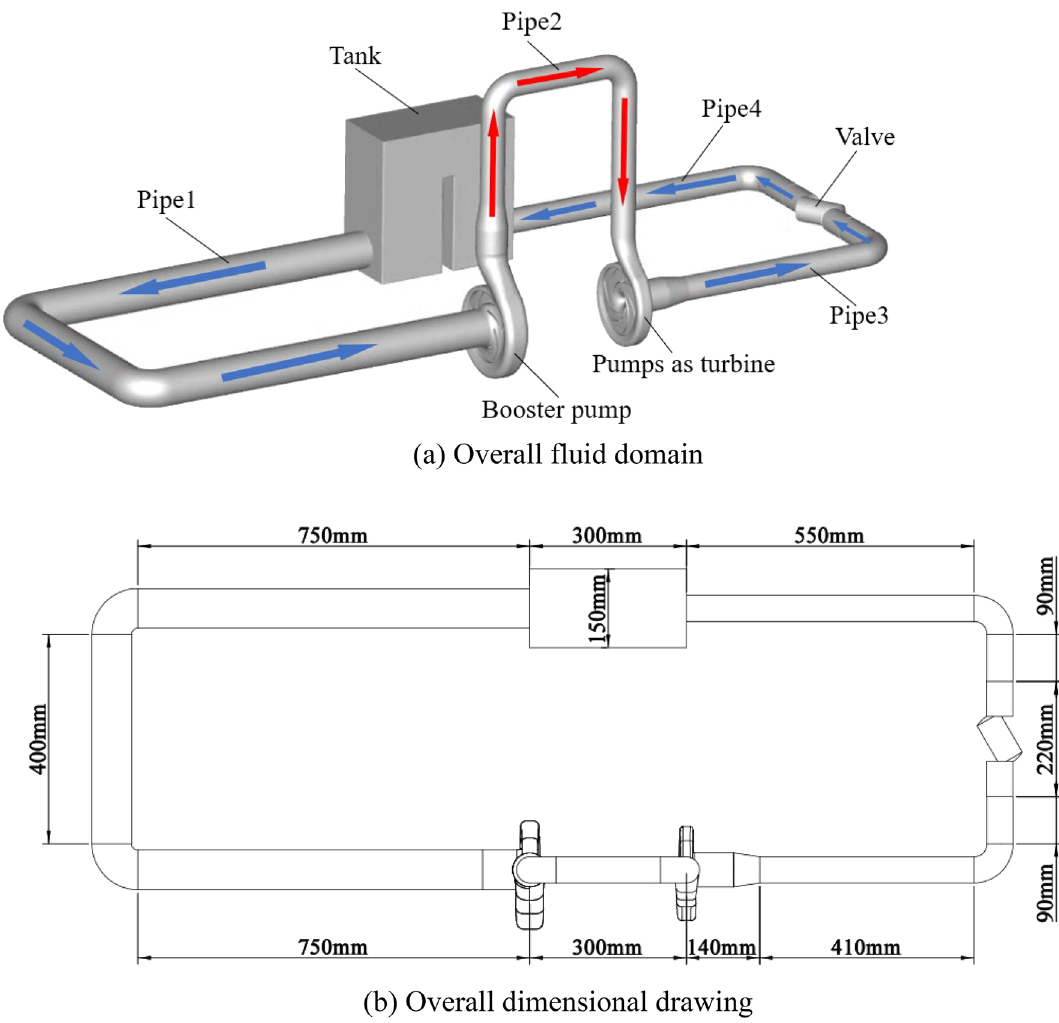
Figure 2. Overall fluid domain of the pump and turbine system. ( a ) Overall fluid domain, ( b ) Overall dimensional